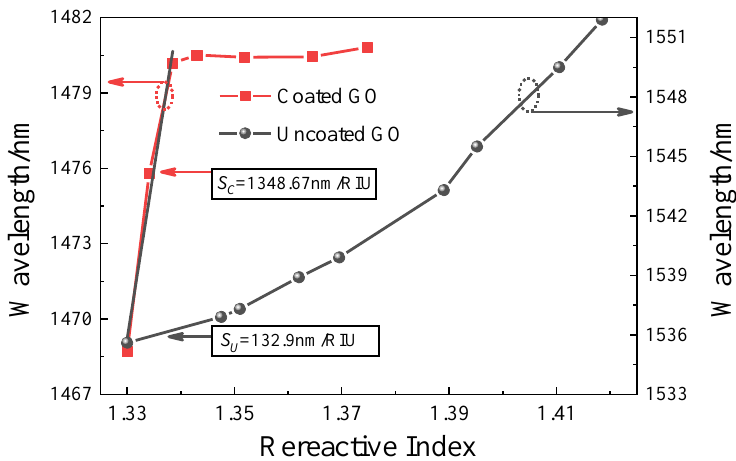
Figure 9. The relationship between the characteristic wavelength and refractive index of coated GO and uncoated GO.